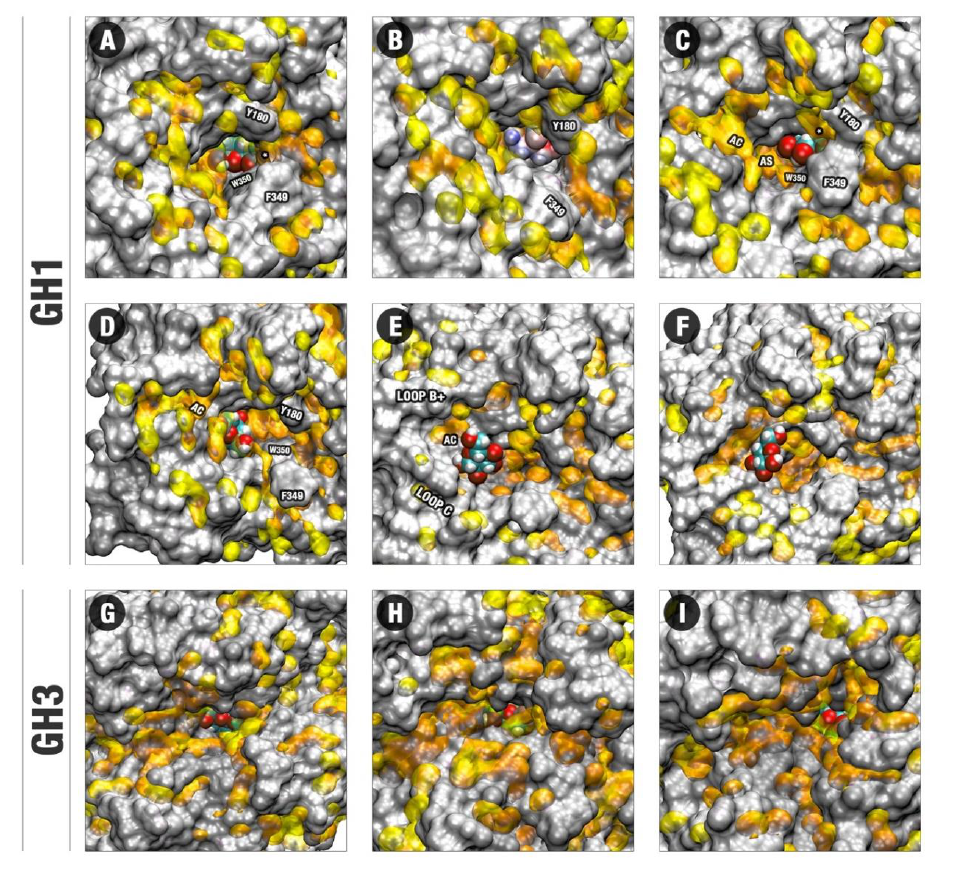
Figure 5. Conformations recovered by the FEL profiles of the glucose positioning in GH1 and GH3, colored by the GIST data. ( A – F ) GIST results and glucose positions occupancy at the respective FEL regions 1–4 and two di ff erent samples of region 5 in GH1 in Figure 2B. ( G – I ) The analog profiles for the FEL respective regions 1–3 in GH3 in Figure 2C. GIST positions are shown in yellow transparent surfaces for water-interacting centers with g v (O) ≥ 10.00 units of the bulk density and ∆ G v solv ≥ + 3.0 kcal / mol. Glucose, shown in spheres in all the figures, is colored with carbons in cyan, oxygens in red, and hydrogens in white (except for B, which was colored by APBS). Residues involved in the establishment of the hydrophobic cage and regions important for the glucose escaping in GH1 are highlighted. AS: Allosteric site. AC: Allosteric channel. A white asterisk (*) is used to point the site for water exclusion confined by the hydrophobic cage between Y180, F349, and W350. The same figure colored by APBS and GIST is available in the Supplementary Materials (Figure